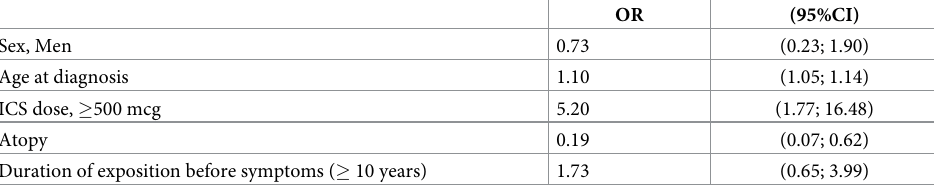
List of abbreviations: ICS, inhaled